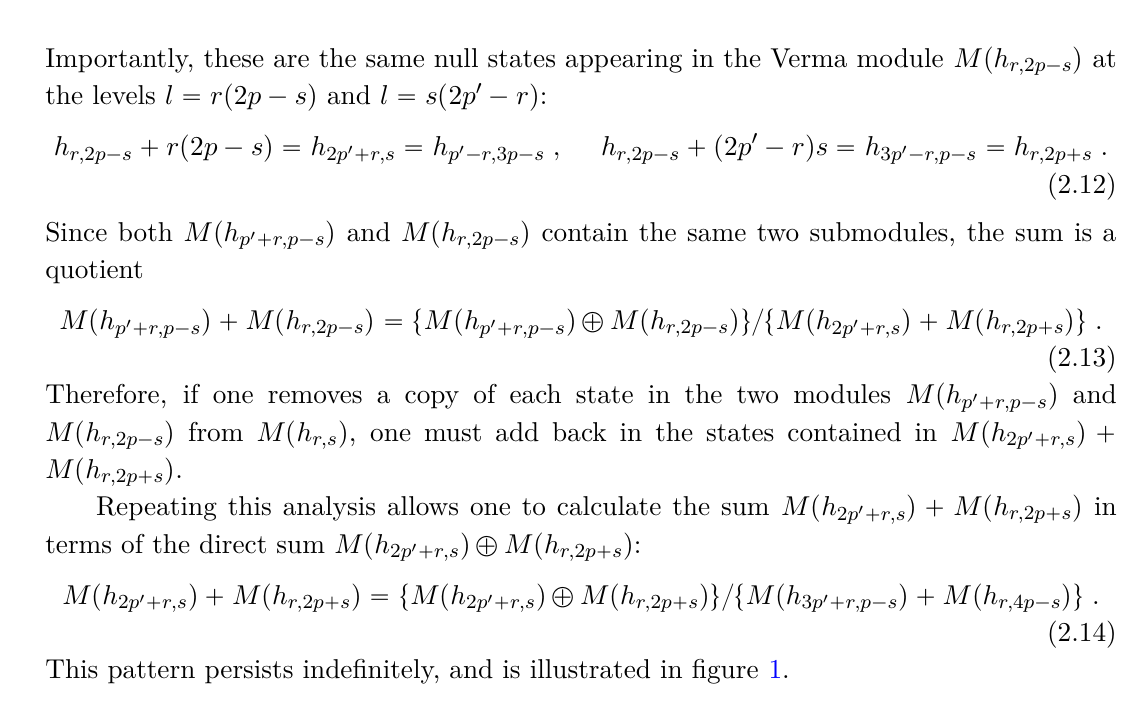
Figure 1 . Structure of reducible Verma modules. An arrow from one point to the next indicates that the highest weight vector of the second module is a singular vector of the first